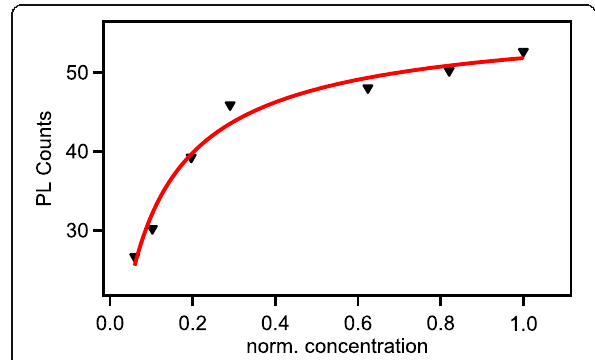
Fig. 8 UV PL intensity vs. normalized concentration